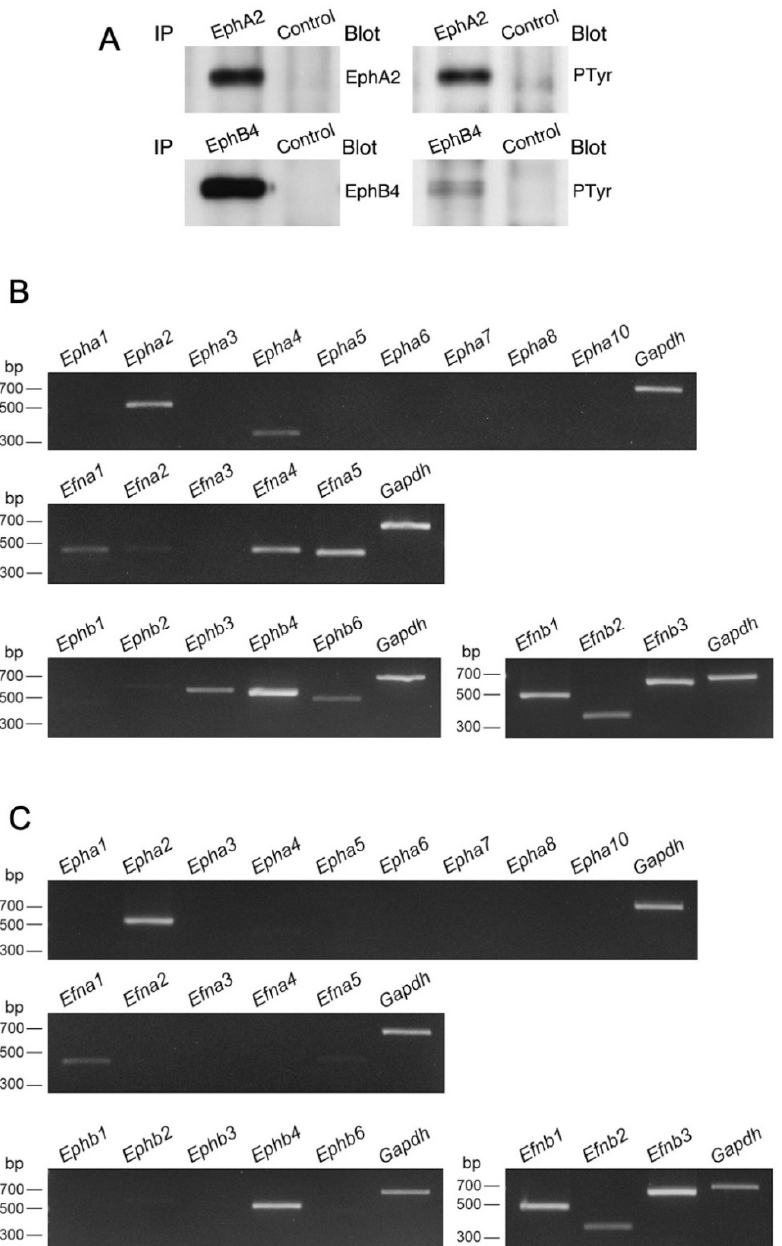
(red) in CD146-positive LSECs (green) and F4/80-positive Kupffer cells (green) in the mouse liver. Cryostat sections were stained with the indicated antibodies and DAPI (blue). Green fluorescence images were merged with red, and/or blue fluorescence images in the same field. EphA2, ephrin- A1, EphB4, and ephrin-B1 immunoreactivity was localized in CD146-positive LSECs and weakly localized in F4/80-positive Kupffer cells (arrows). M, marginal region of the hepatic lobules; Pc, pe- ricentral region of the hepatic lobules.